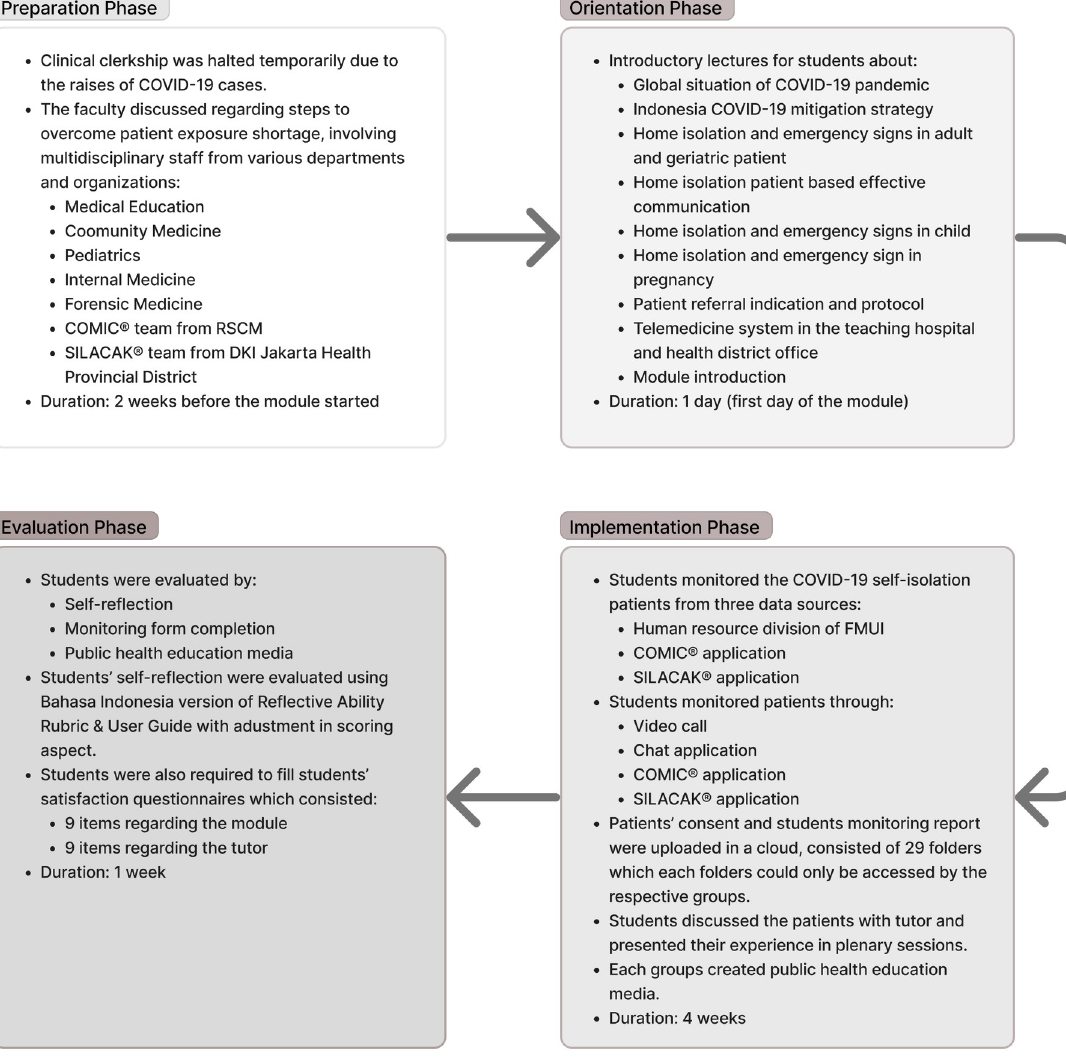
Fig 1. The summary of module organization